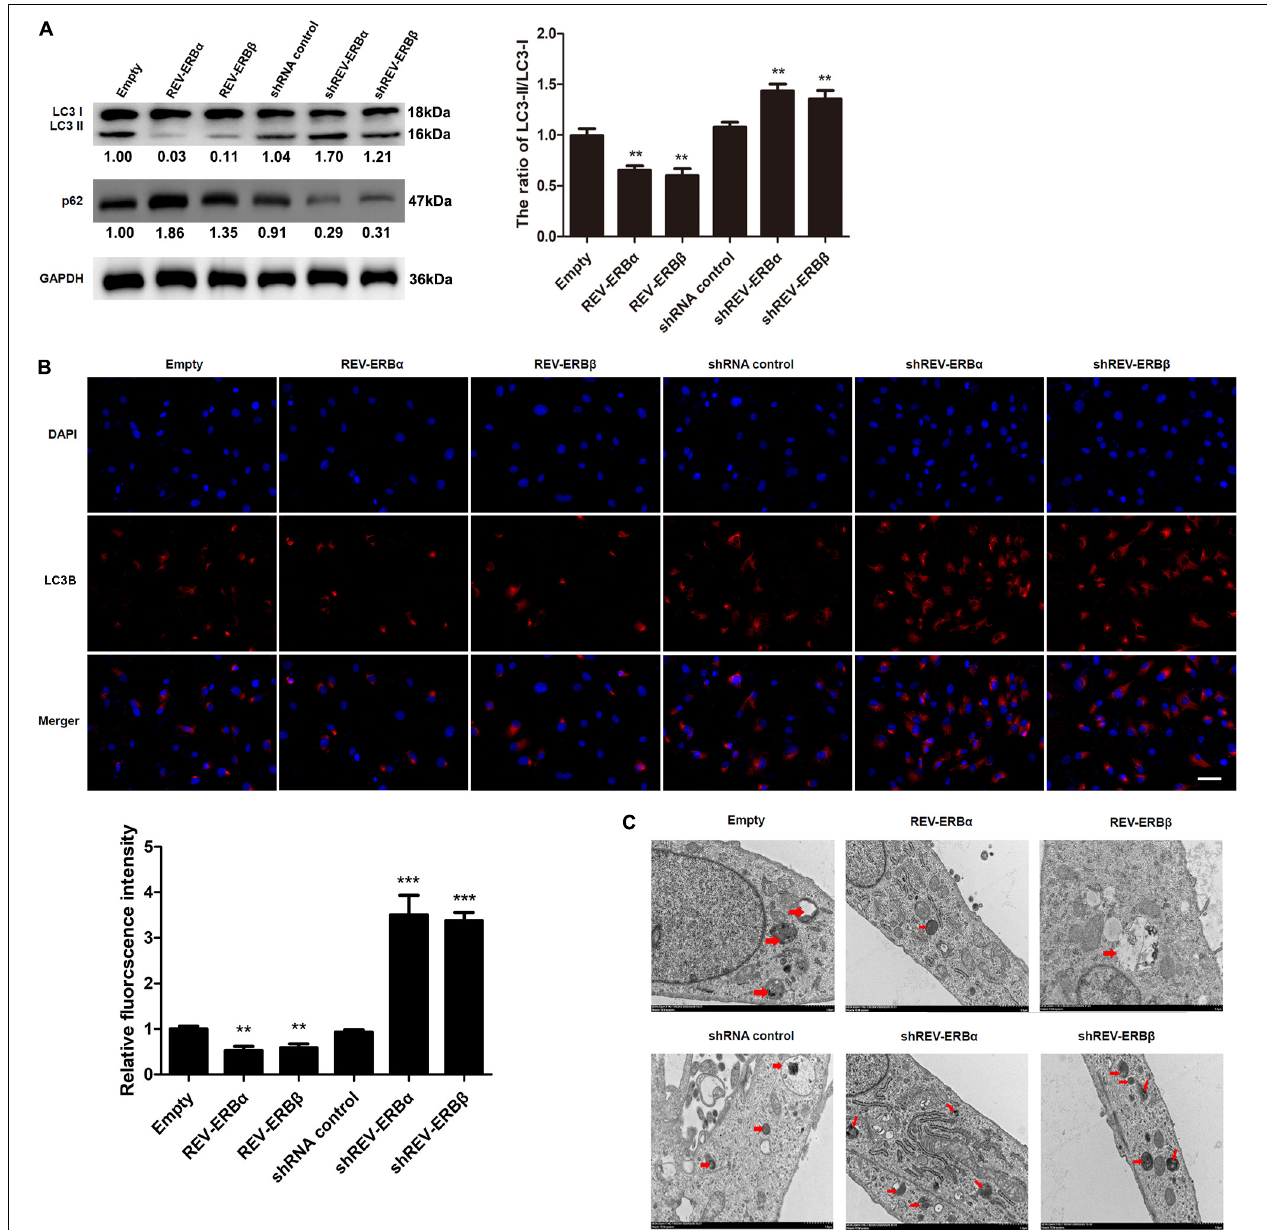
FIGURE 3 | Overexpression of REV-ERBs inhibits autophagy in KGN cells. KGN cells transfected with empty vector, REV-ERB α , REV-ERB β , shRNA control, shREV-ERB α , or shREV-ERB β plasmids for 48 h. (A) The expression of LC3 and p62 in KGN cells was detected by western blotting. (B) The expression of LC3B in KGN cells was detected by immunofluorescence. Scale bars: 50 µ m. Blue fluorescence represents DAPI staining; Red fluorescence represents LC3B expression. (C) Morphological observation of autophagy in KGN cells under transmission electron microscopy. Arrows indicate autophagosomes or autolysosomes. Scale bars: 1.0 µ m. ** P < 0.01, *** P < 0.001 vs. empty